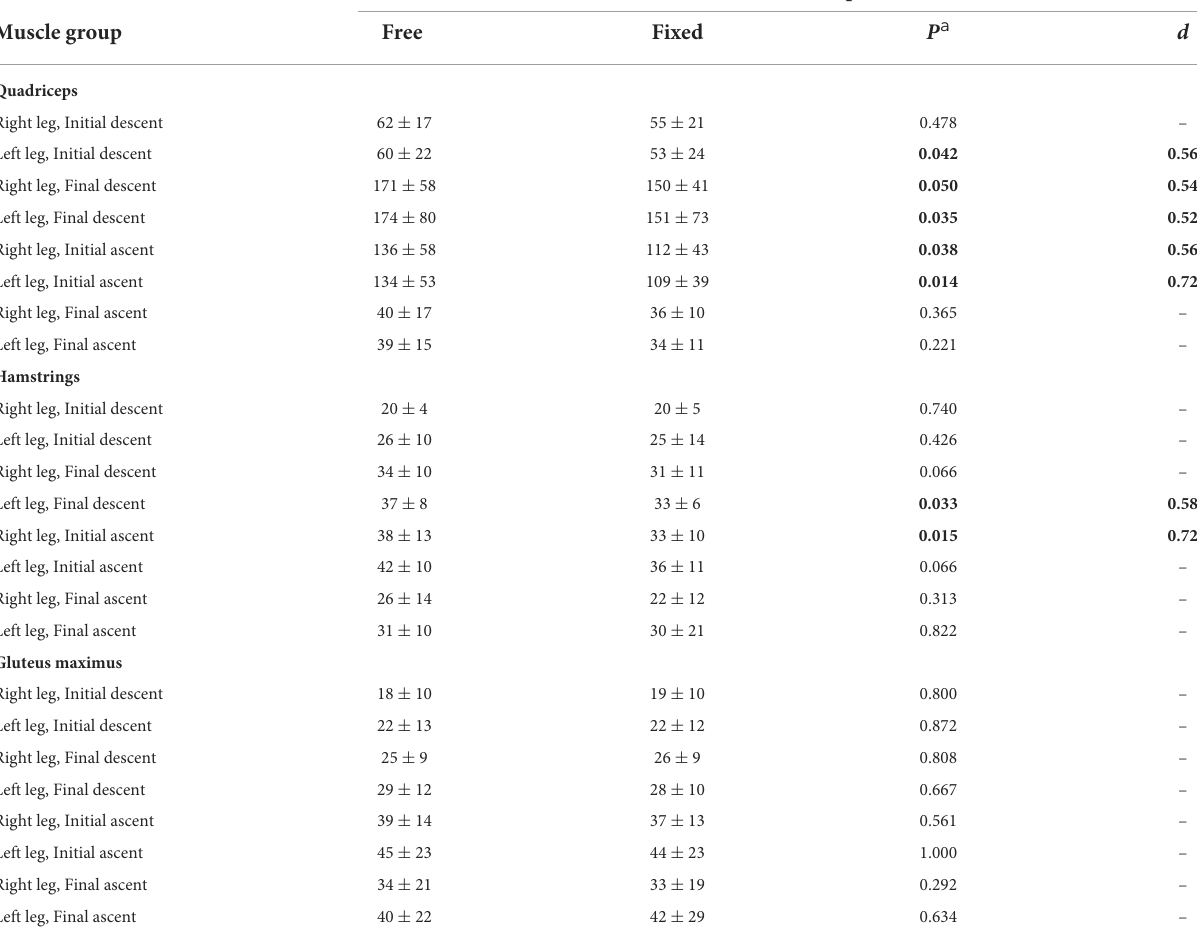
TABLE 2 Mean ± standard deviation of muscle activation (min µ V) for each second of the mid three repetitions of the loaded barbell squat in quadriceps, hamstrings and gluteus maximus when performed in a free movement path and in a fixed vertical movement path, respectively ( n = 16). Barbell movement